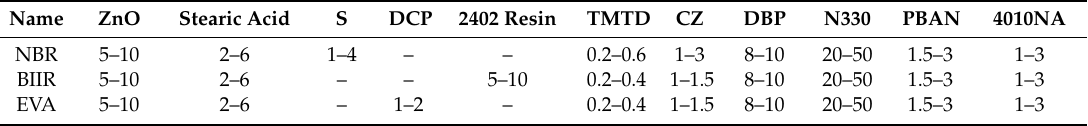
Table 1. Basic formulation of nitrile rubber (NBR), brominated butyl rubber (BIIR) and brominated butyl rubber (EVA) (100 phr).